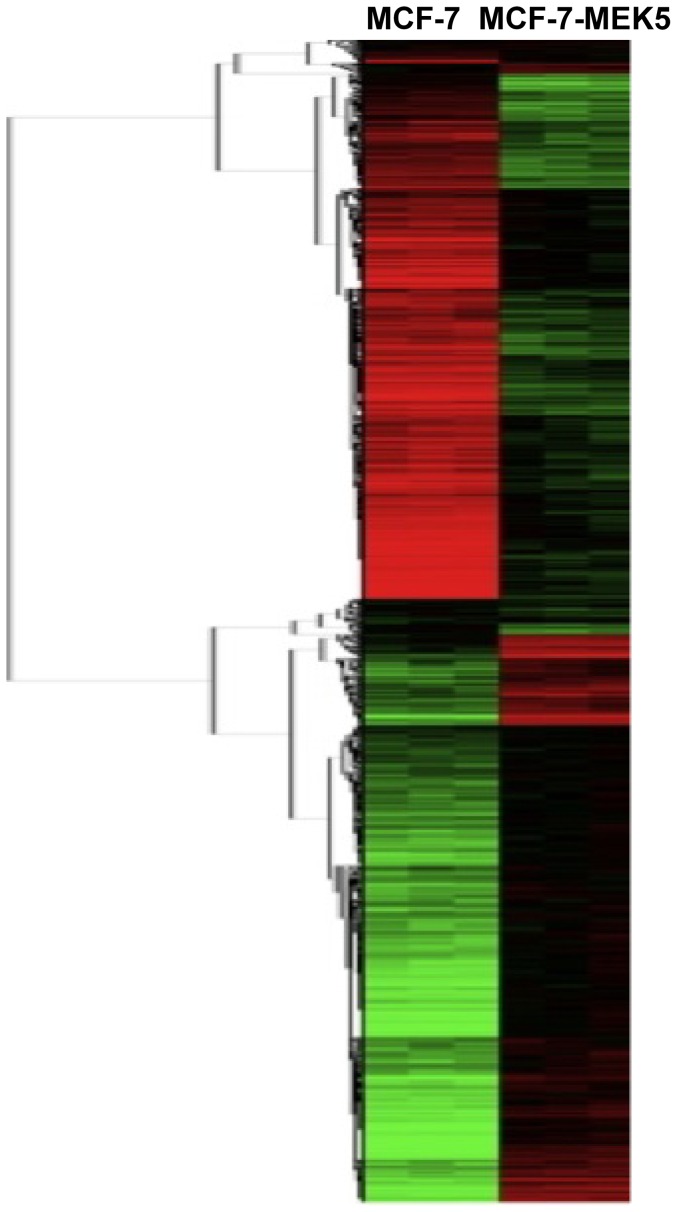
Clustering analysis of mRNA expression profiles of MCF- 7 and MCF-7-MEK5 cells.Microarray results demonstrating MCF-7 (left column) and MCF-7-MEK5 (right column) cell lines have distinctive gene expression patterns, with samples of same cell lines clustered together. Trees on the left are gene clusters. Data represented as mean ± S.E.M. of 3 independent experiments.